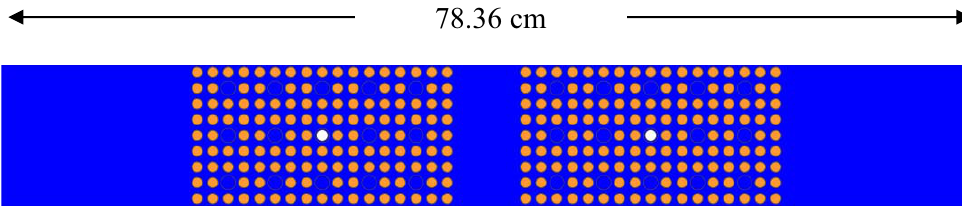
Figure 1. X-Y view of the UOX – UOX geometry, with a water blade of 5.04